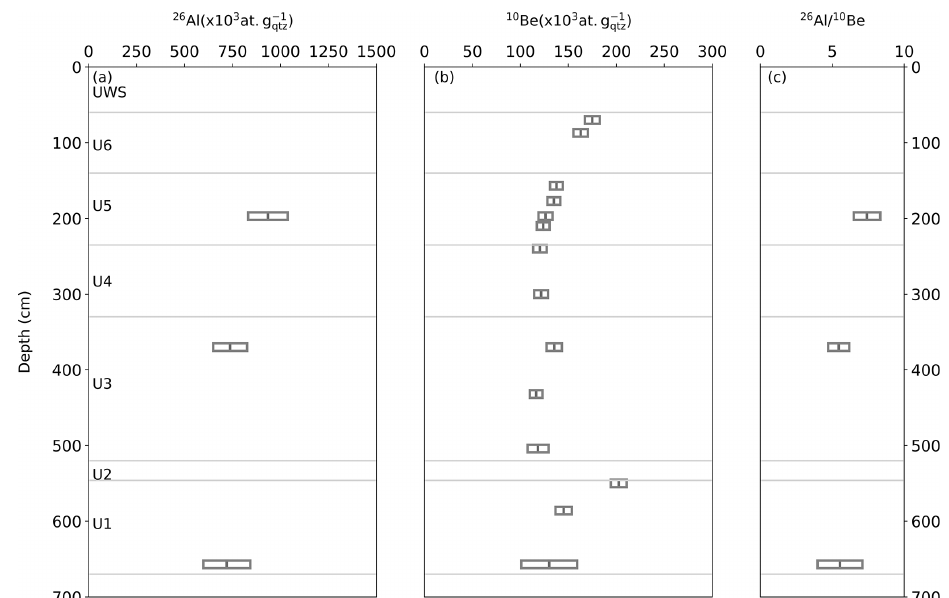
Figure 6. Panels (a) and (b) present the 26 Al and 10 Be concentration and (c) the 26 Al / 10 Be ratio. The reported uncertainties are 1 standard deviation (1 σ ).